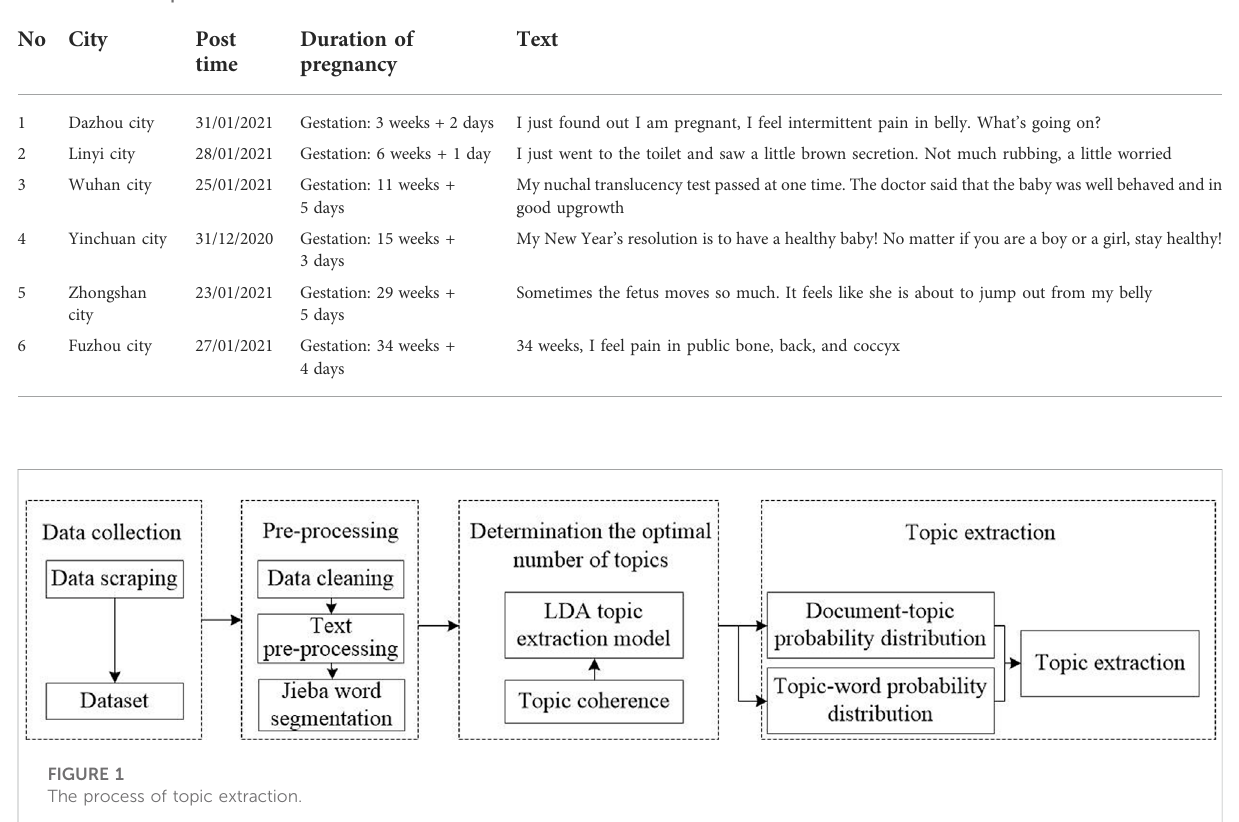
TABLE 1 The examples of dataset.